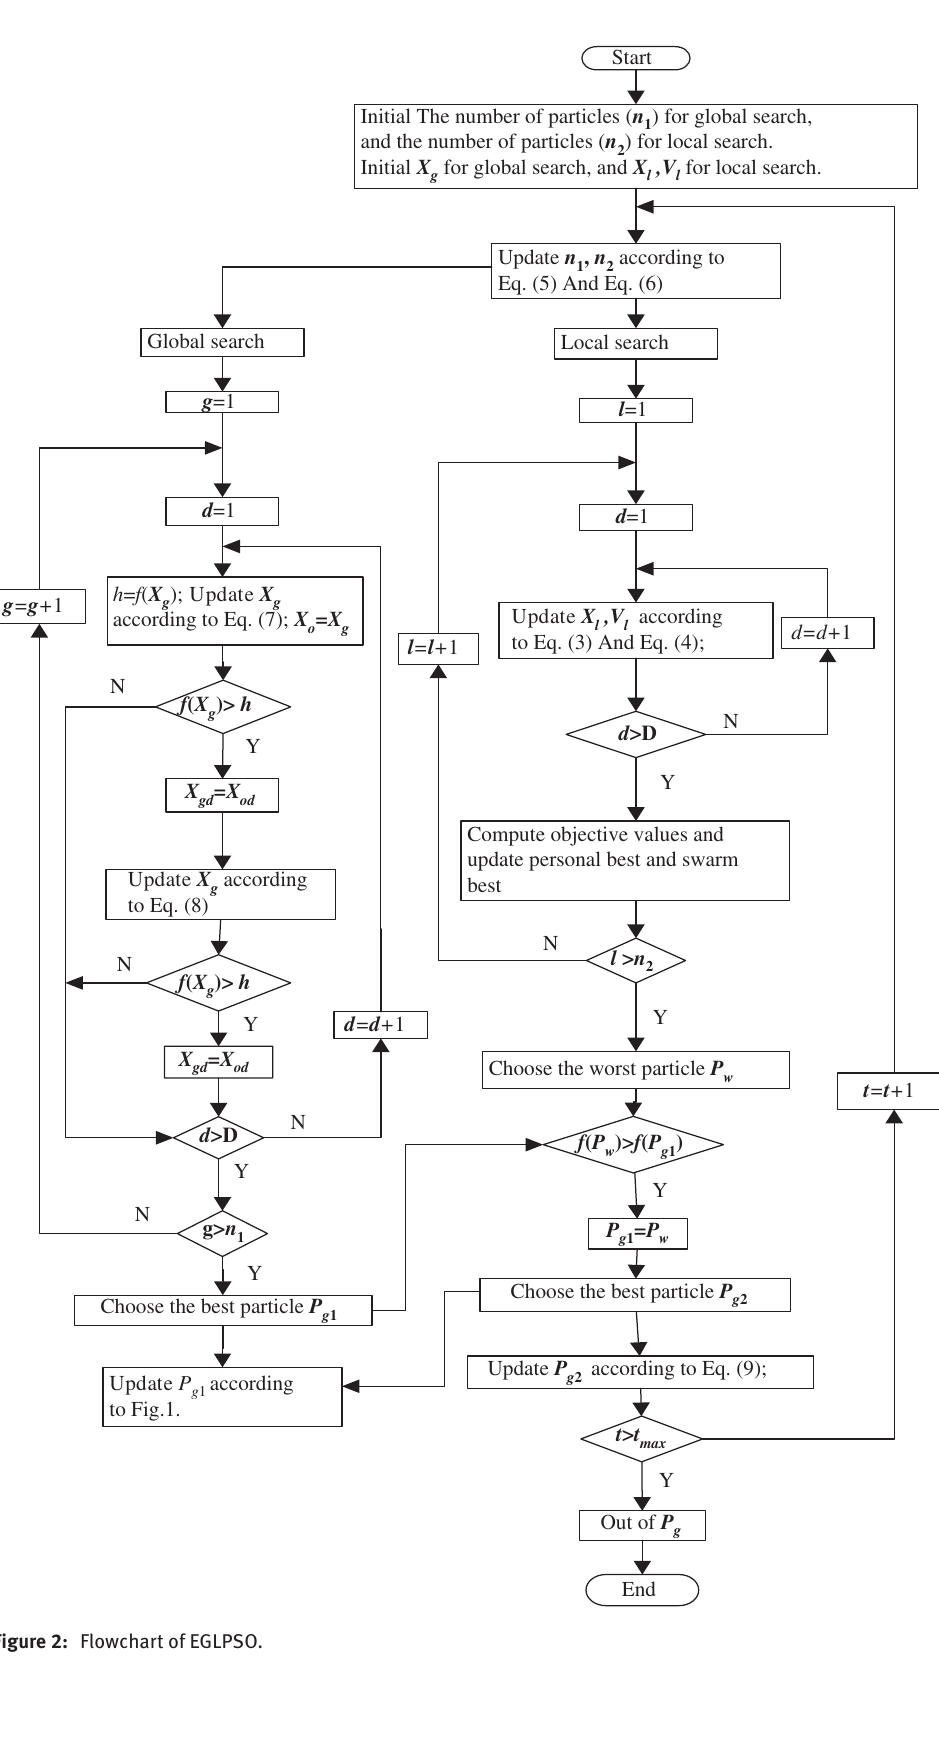
Figure 2: Flowchart of